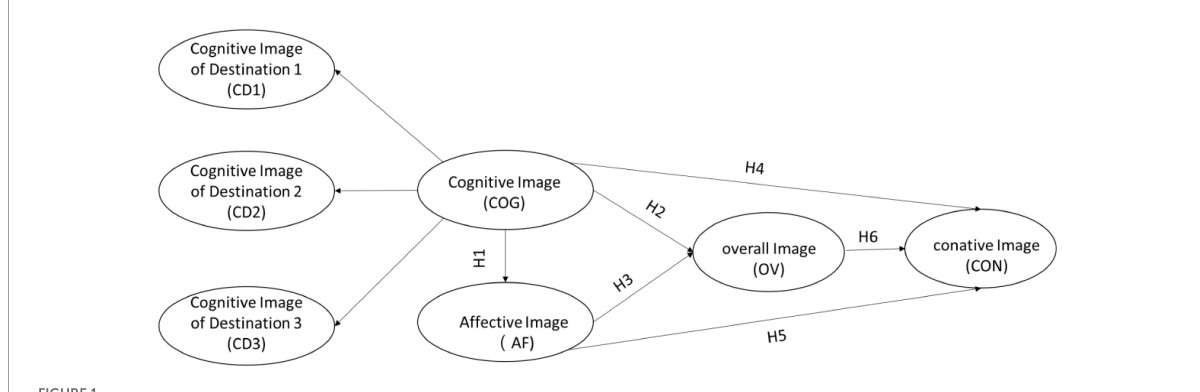
FIGURE1 Research